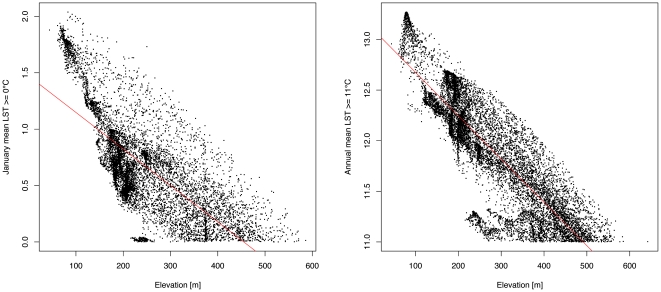
Relationship between the JanTmean LST (left) and the AnnTmean LST (right) and elevation.All the pixels with a JanTmean LST > = 0°C and with an AnnTmean LST > = 11°C were included and compared with elevation.